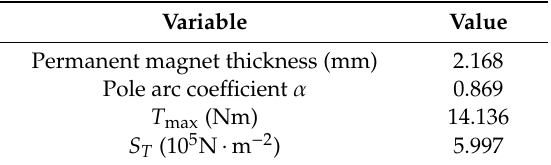
Table 4. Optimum design parameters and objective